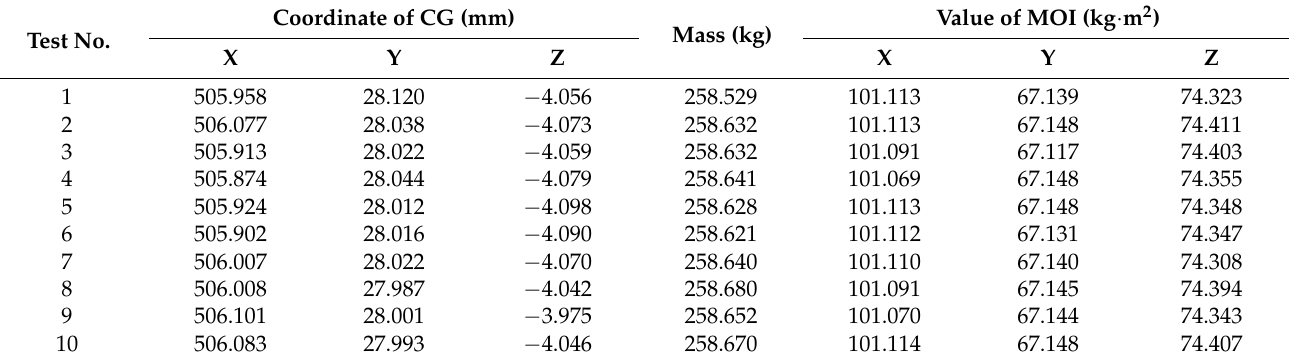
Table 3. Measurement results of mass properties.